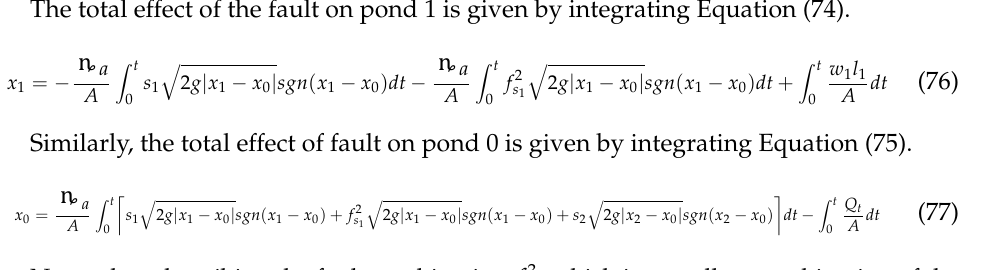
Figure 1. Three-pond hydraulic system.